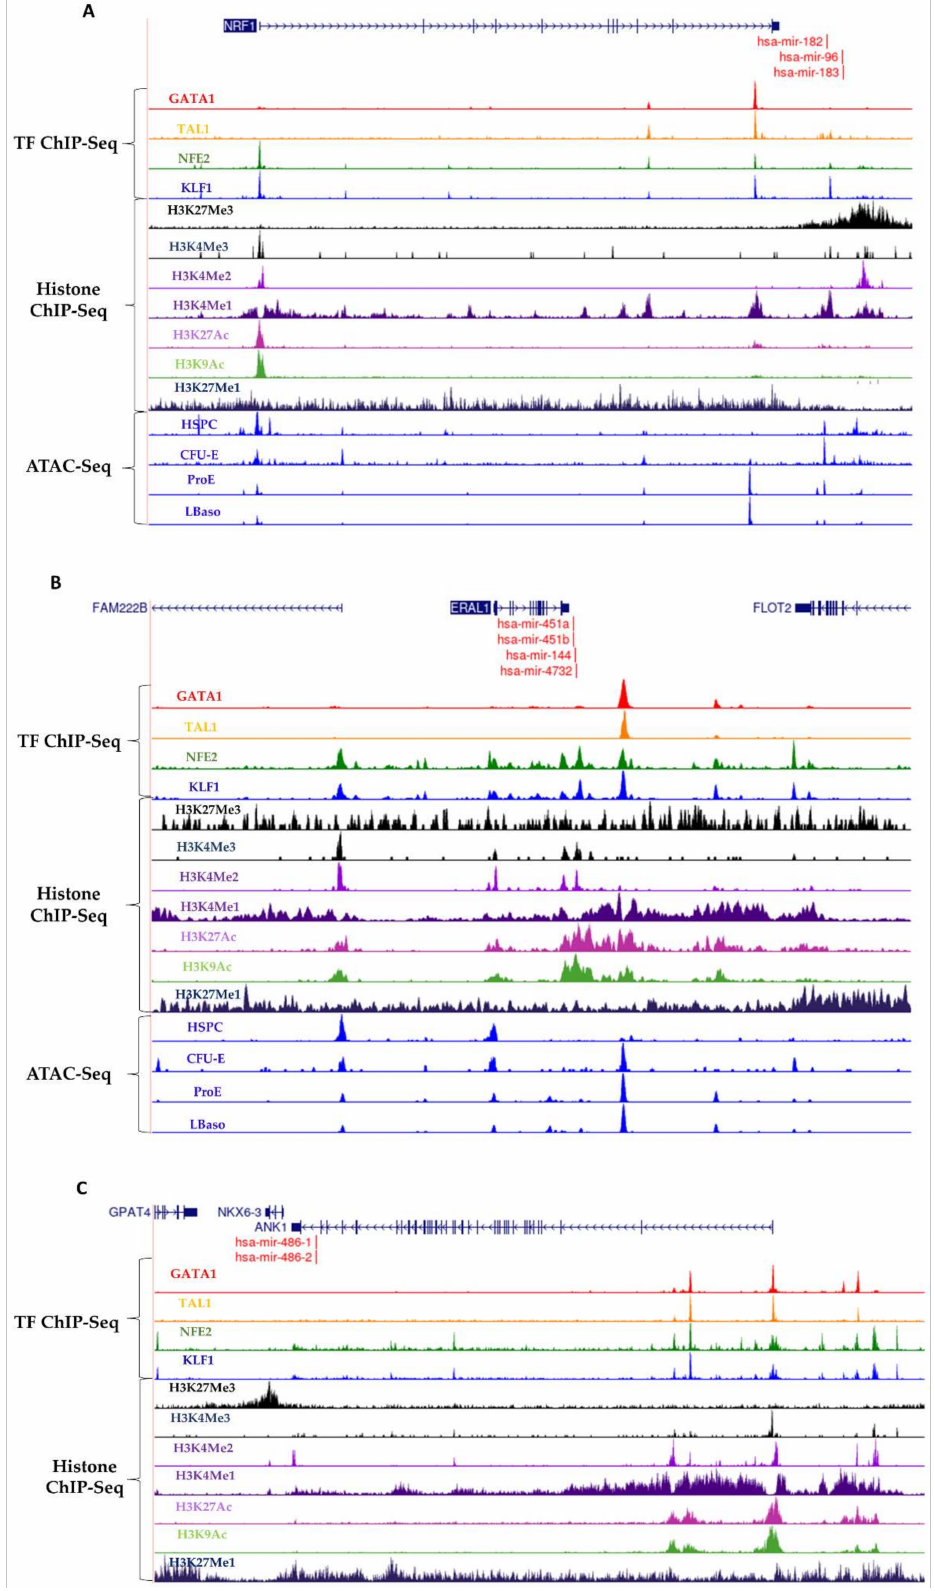
Figure 3. ChIP-Seq density plots of erythroid TFs and histone modifications and ATAC-Seq peaks at the genomic regions of three most upregulated miRNA clusters in human erythropoiesis; ( A ) miR182-183-96 cluster, ( B ) miR 451a-144-4732 cluster, and ( C )